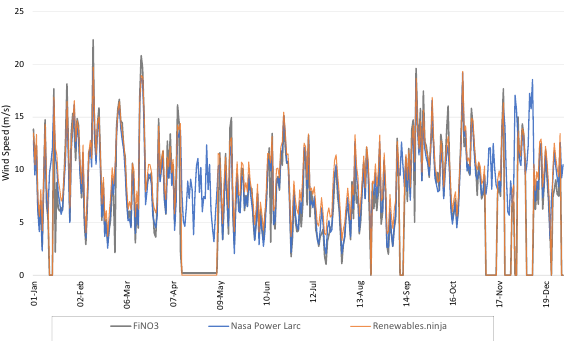
Figure 23. Yearly comparison (2018). Own